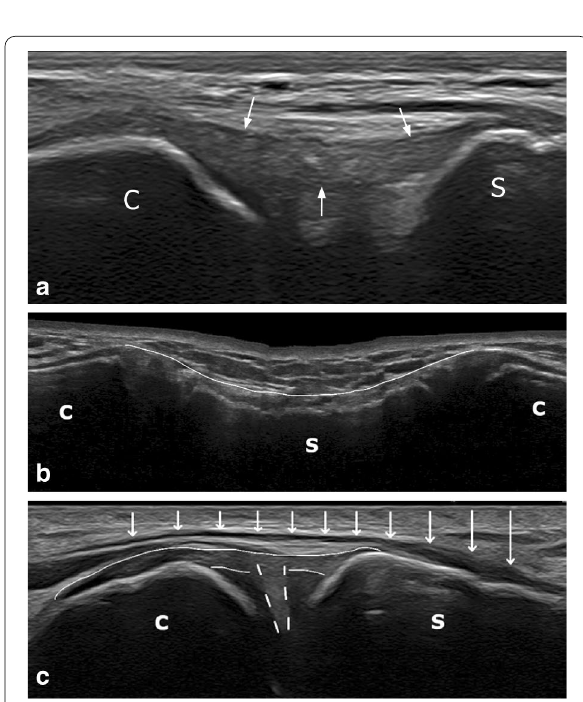
Fig. 3 Ligaments and tendons of the sternoclavicular region. a Anterior sternoclavicular ligament (white arrows) (upward and outward oblique transverse plane). b Interclavicular ligament (white arrow indicating anterosuperior aspect) attached on sternum (transverse plane with caudal tilt). c Longitudinal view of sternal tendon of the sternocleidomastoid muscle (white arrows) covering the medial aspect of the sternoclavicular joint (slightly upward and outward oblique sagittal plane). White broken lines show the articular disc, thin white lines show the anterior sternoclavicular ligament. C, Clavicle; S,